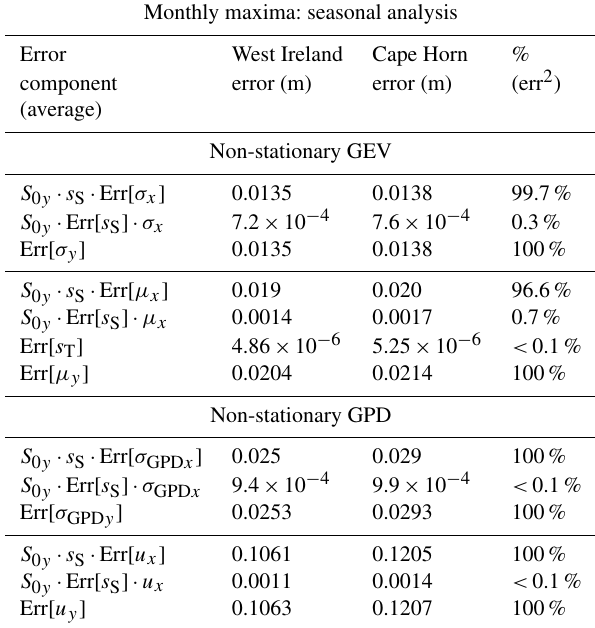
Table 2. Average error components for the seasonal analysis of the projections of significant wave height extracted at west Ireland and Cape Horn, for non-stationary GEV and GPD. The error is domi- nated by the component due to the stationary